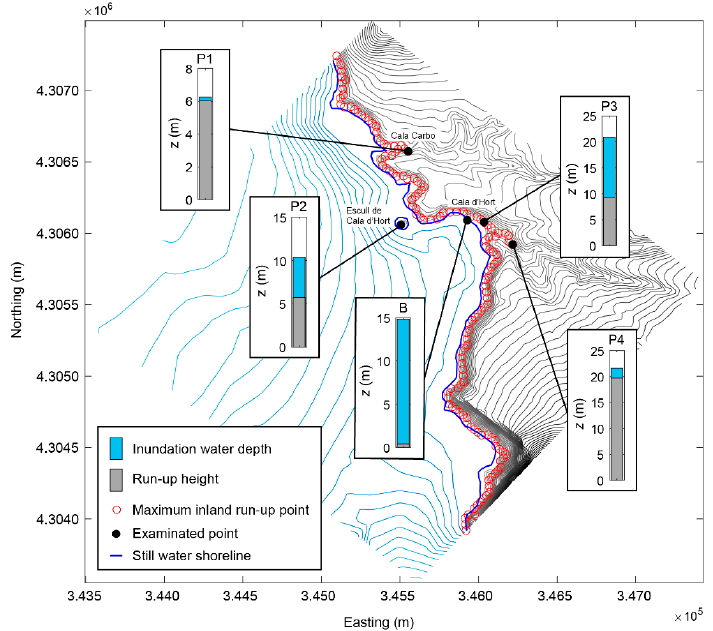
Figure 10. Maximum run-up heights and water depths at different points of interest in scenario 1.